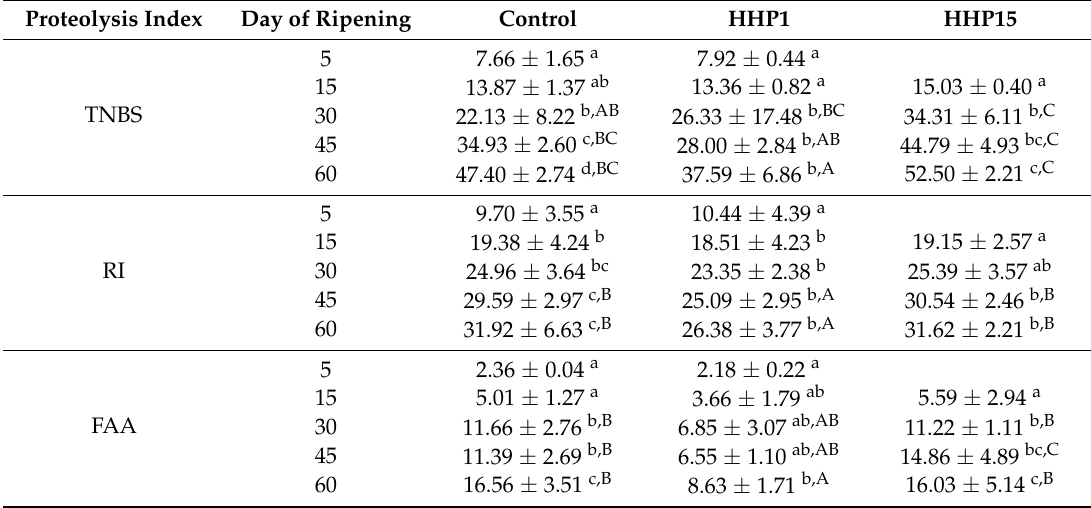
Table 4. Evolution of proteolysis index (mean values ± standard deviation) during the ripening of ewes’ raw milk cheese samples with and without HHP